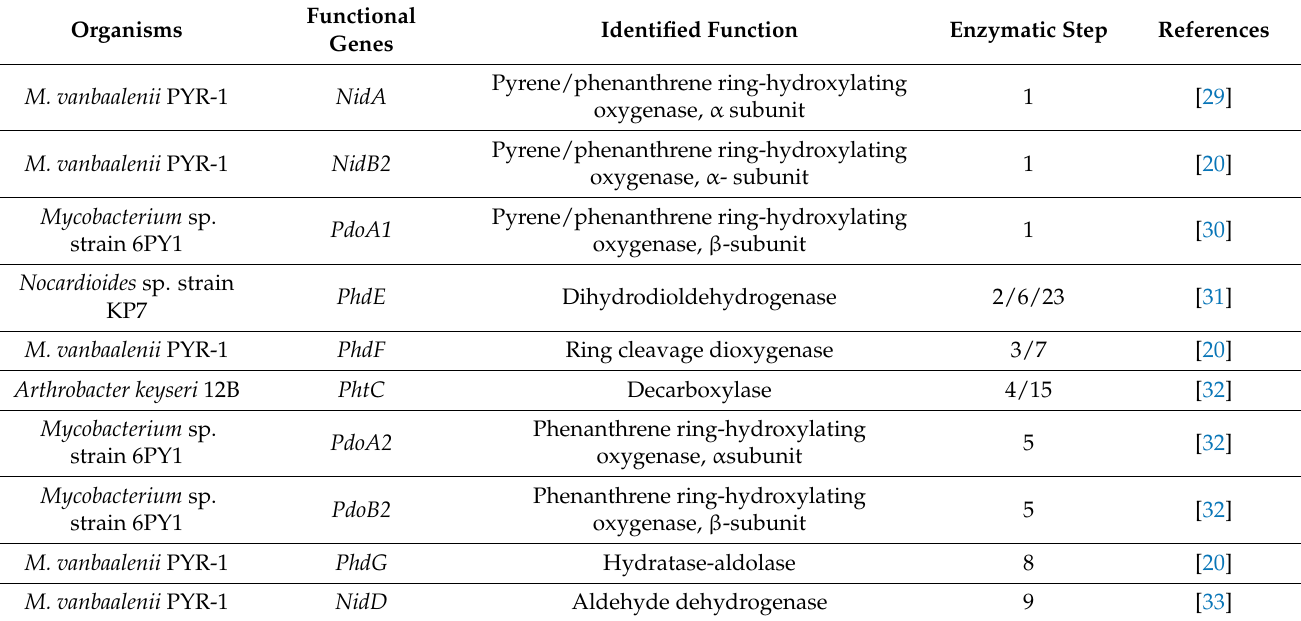
Table 1. Different key enzymes and functional genes involved in the pyrene metabolic pathway identified in different bacterial strains including M. vanbaalenii PYR-1 grown in the presence of pyrene.